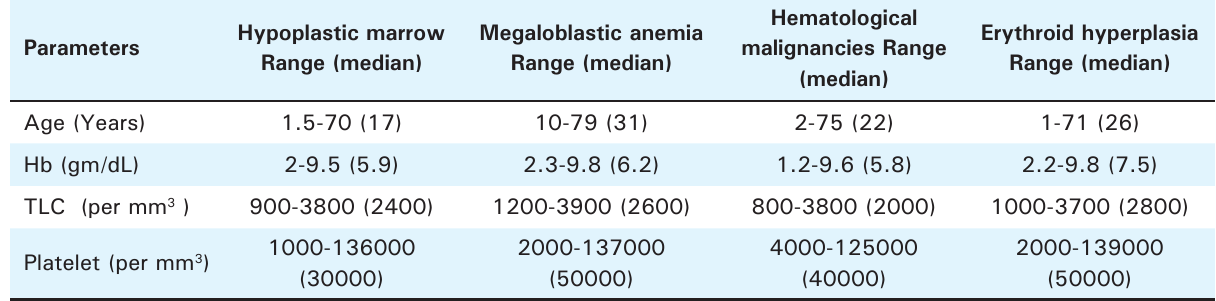
Table 4. A comparison of age and common hematological parameters in 4 common bone marrow fi ndings in cases of